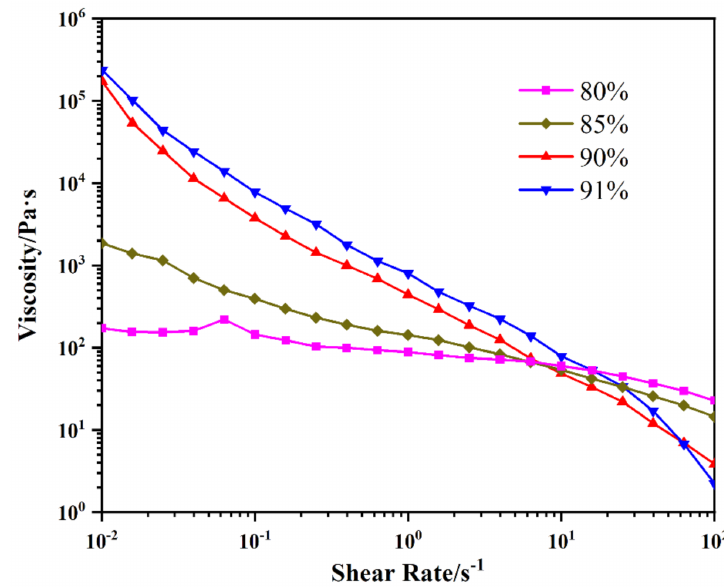
Figure 3. Rheological properties of slurry with different solid